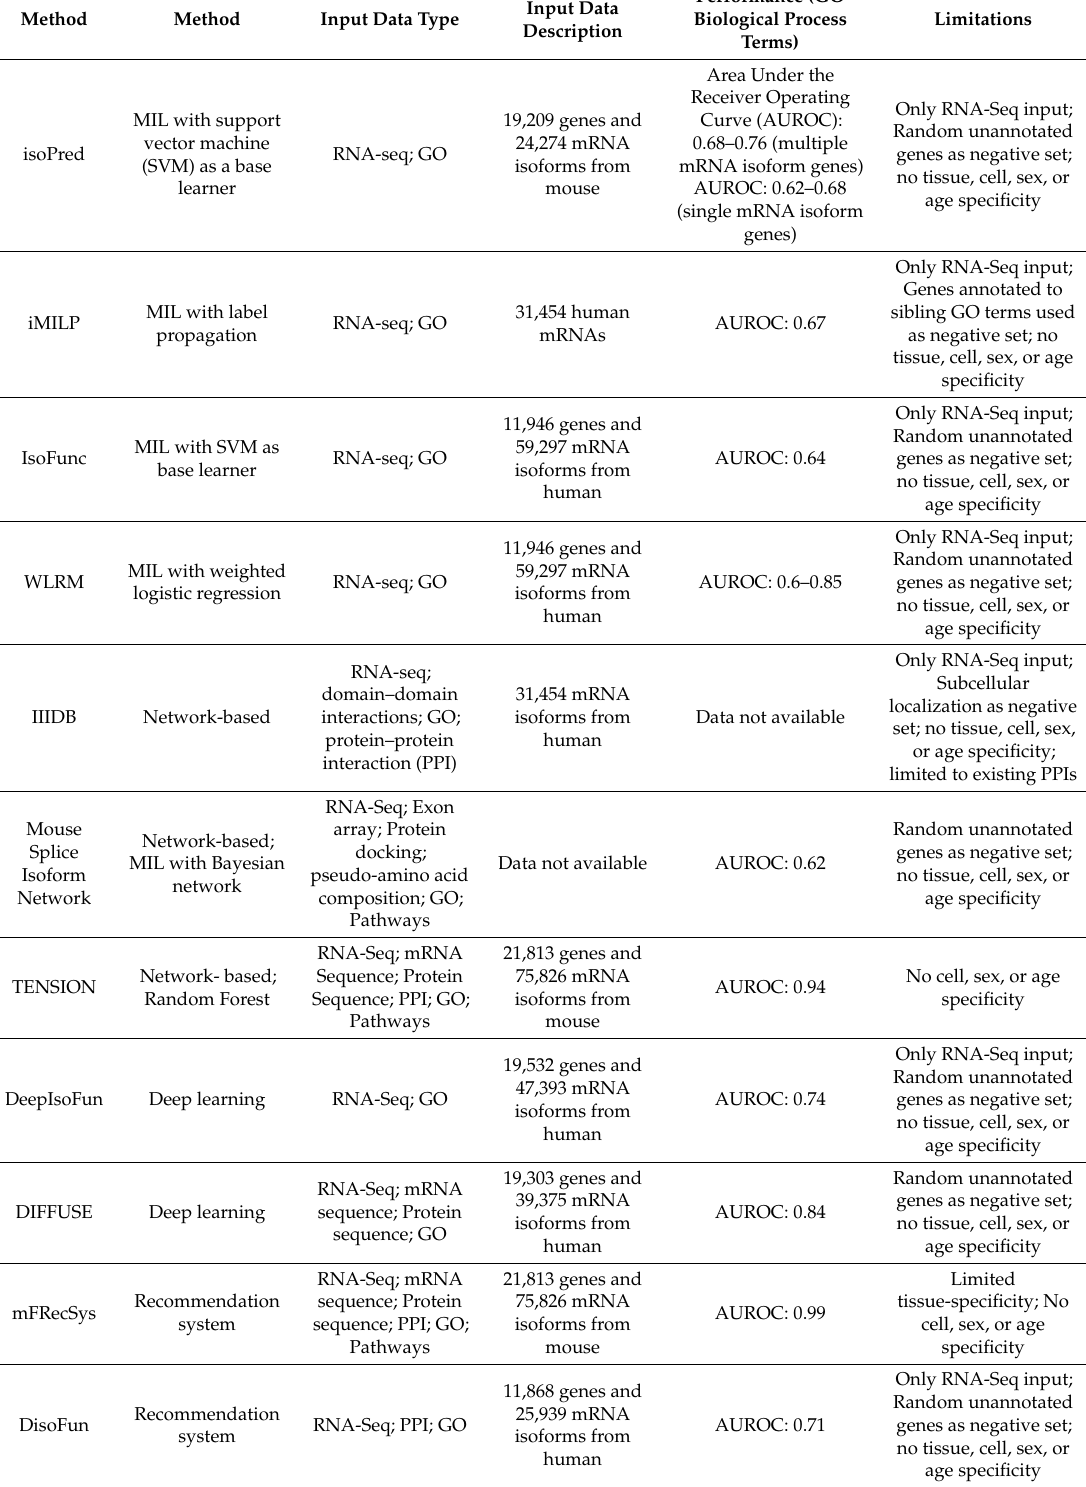
Table 2. Summary of methods reviewed based on their input data type and